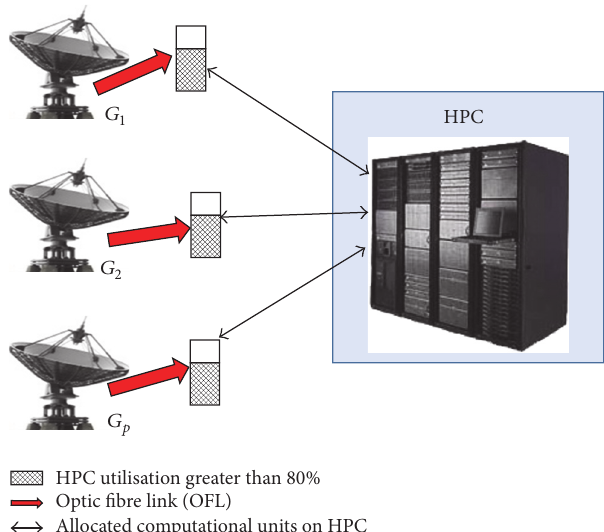
Figure 3: Near optimal HPC